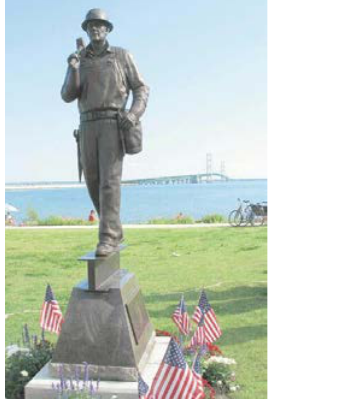
Fig. 4 the bronze statue of the Ironworker, Michigan, US, appreciating the makers of Mackinac bridge 1950